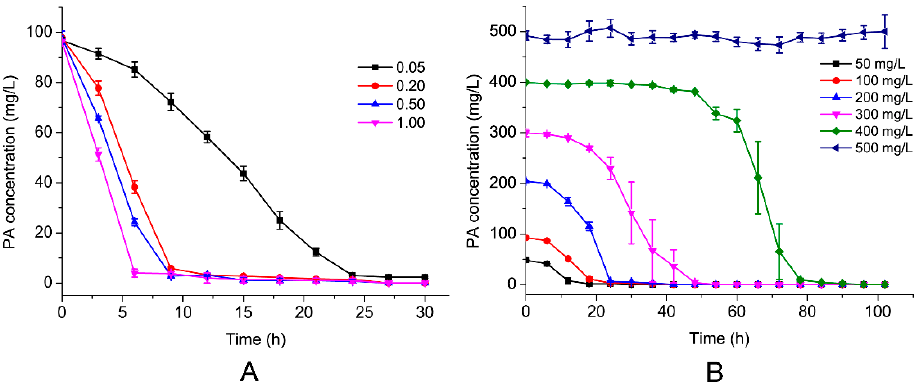
Figure 3 . Effects of inocula ( A ) and the initial PA concentration ( B ) on the degradation of PA in MSM. The error bars show standard deviations.